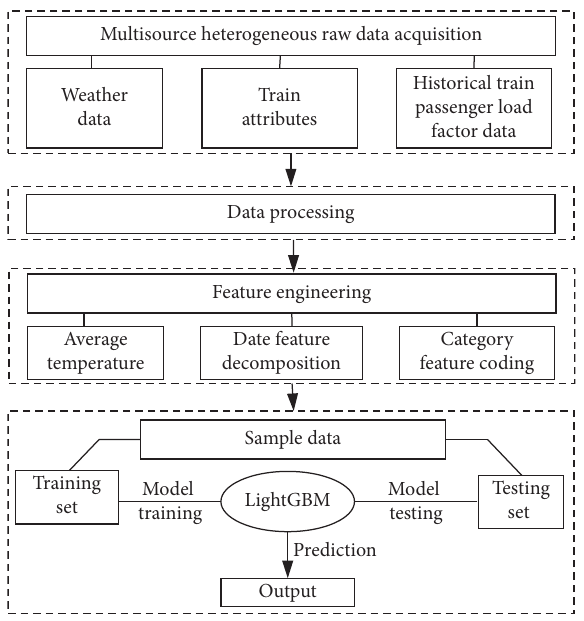
Figure 2: Overall framework of prediction model.